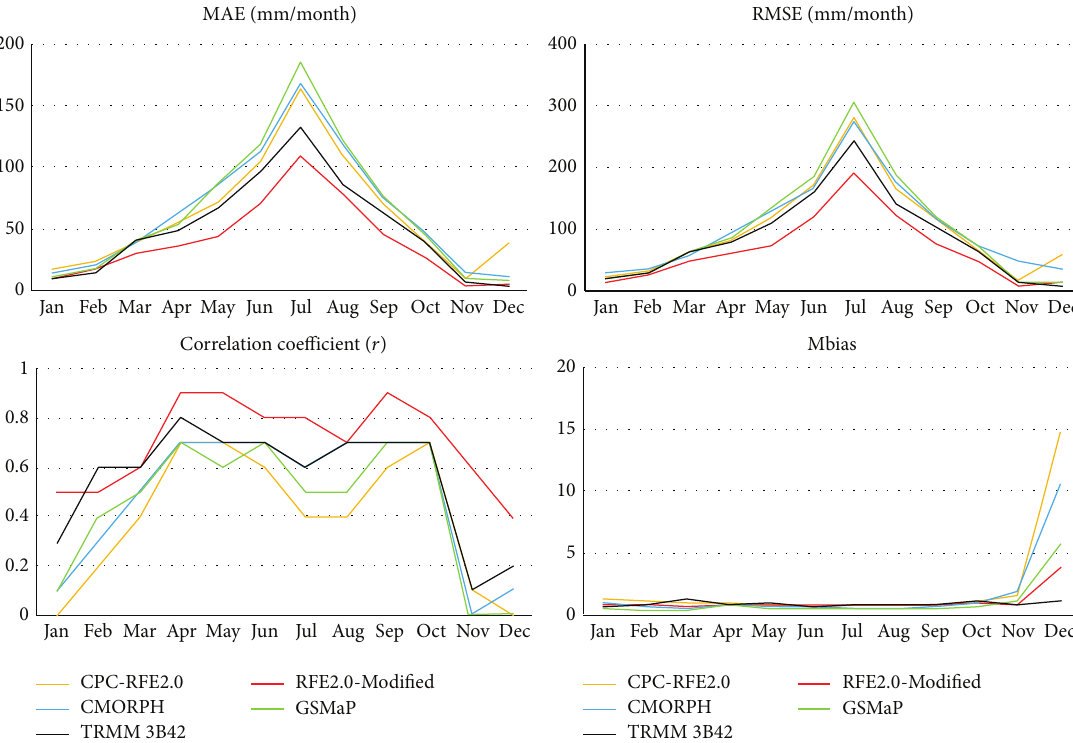
Figure 7: Monthly rainfall error statistics of different satellite products for 2004 to 2006 (G-G